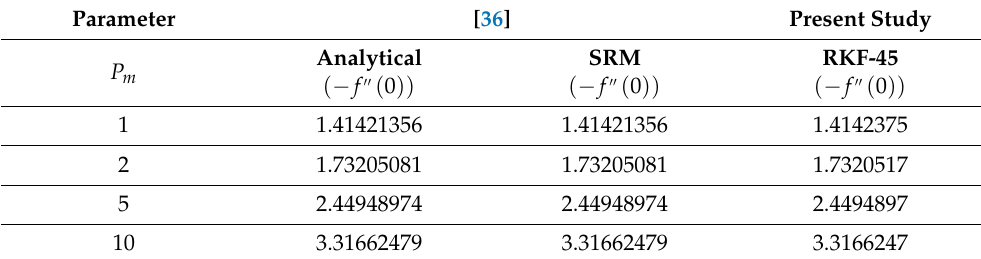
Table 2. Comparison of present numerical scheme with the work of [36] in the absence of δ 1 , γ 1 , B 1 , and B 2